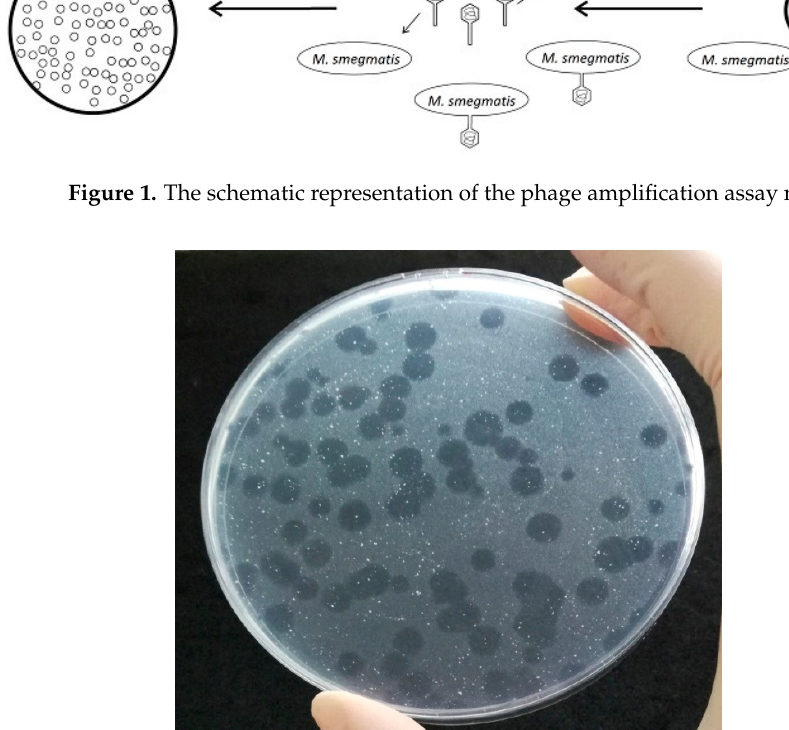
Figure 2. The positive sample determined by phage amplification assay.